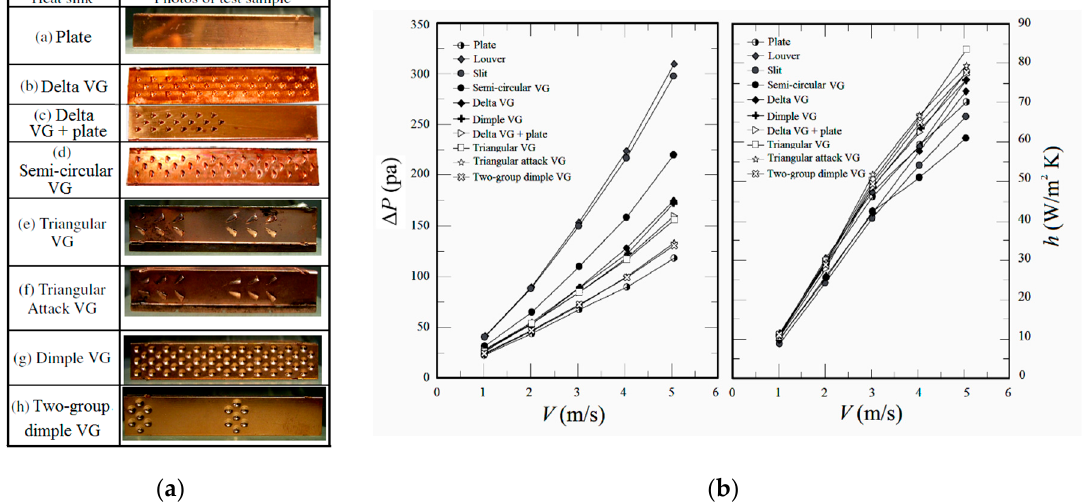
Figure 5. VGs with different configurations [50]. ( a ) Physical model and relevant geometrical parameters. ( b ) Pressure drop and heat transfer coefficients.